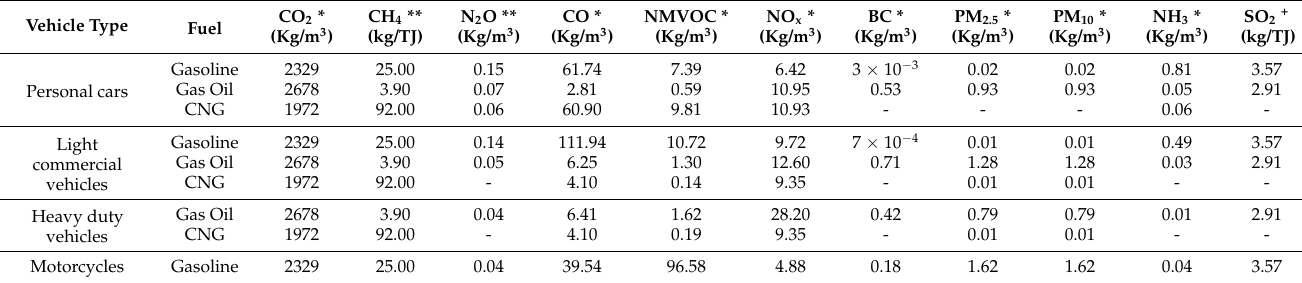
Table A1. Emission factors by vehicle classification and fuel type.